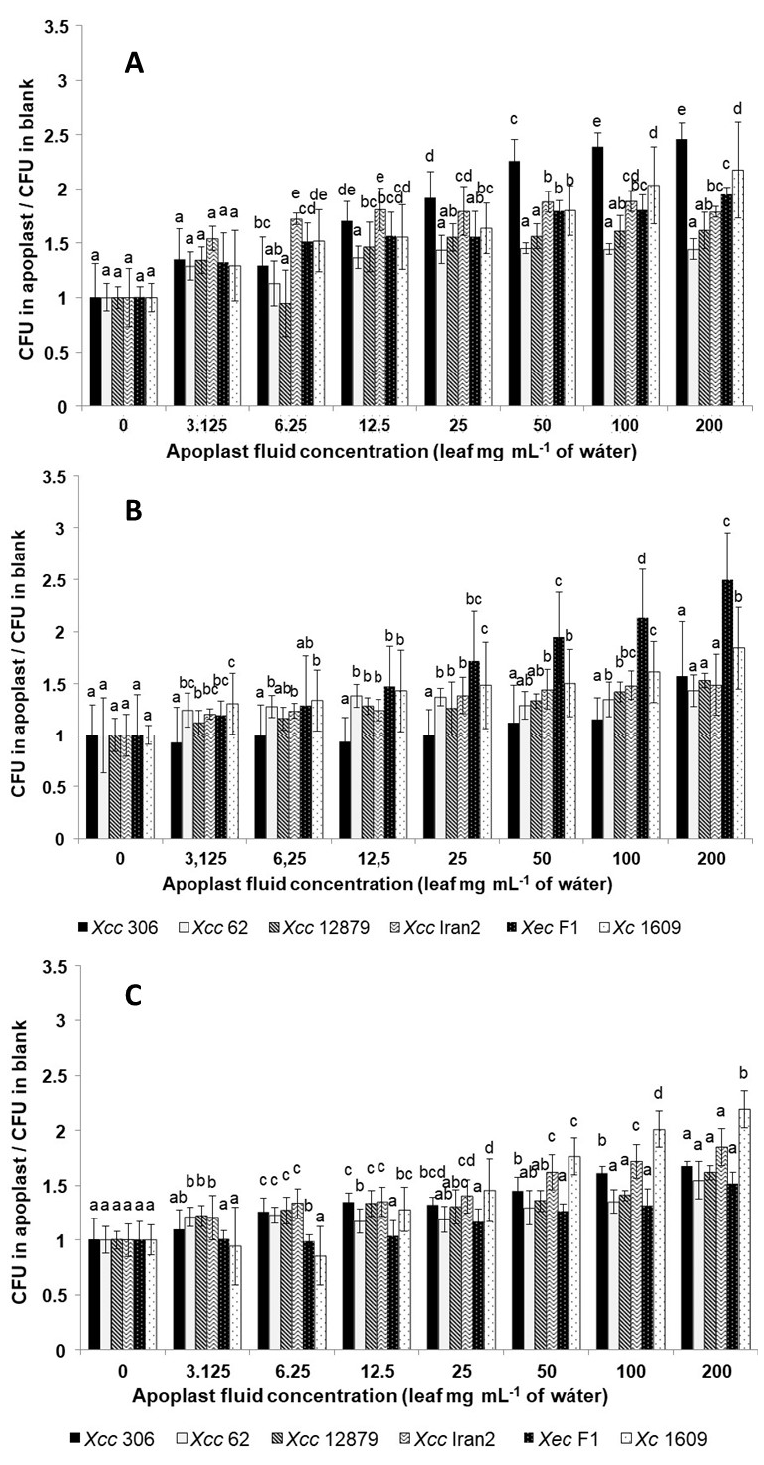
Figure 3. Comparison of the chemotactic response of different Xanthomonas strains to apoplastic fluid extracts from leaves of ( A ) sweet orange, ( B ) Mexican lime and ( C ) Chinese cabbage. The graphs show the relative number of bacteria entering the tip in the presence of an apoplastic fluid at different concentrations. The graph shows the mean with the standard deviation (error bars). Means with the same letter within a sample do not differ significantly ( P < 0.05).